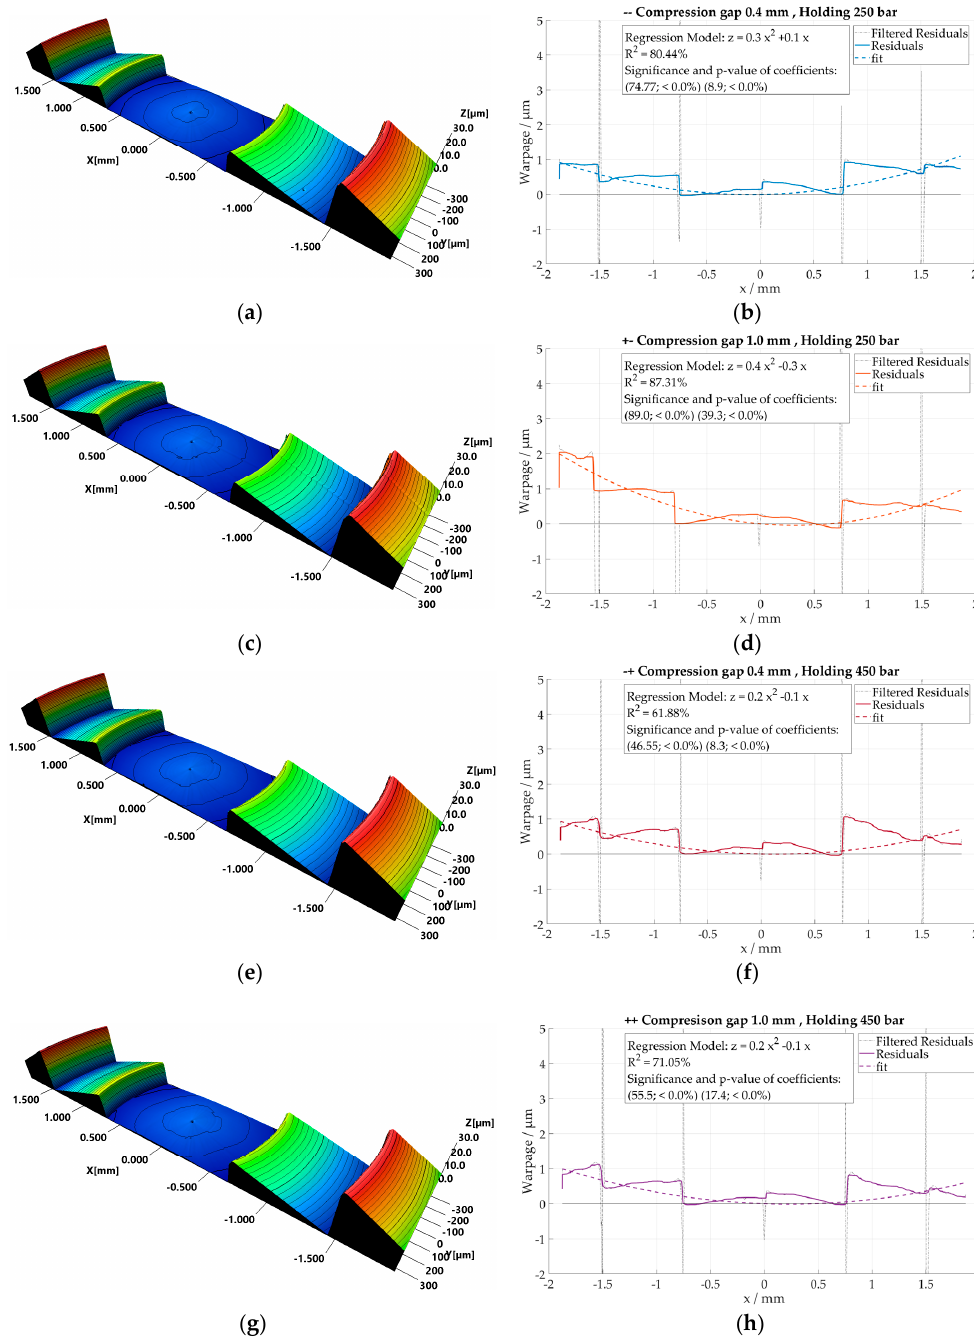
Figure A3. On the left, 3D view of the lens’ central location sampled as in Figure 5. On the right, the residuals of the respective x profiles in comparison with nominal geometry, sampled in the image center. The following process conditions are considered for COP material results: ( a , b ) Compression gap 0.4 mm and holding pressure 250 bar; ( c , d ) Compression gap 1.0 mm and holding pressure 250 bar ( e , f ) Compression gap 0.4 mm and holding pressure 450 bar; ( g , h ) Compression gap 1.0 mm and holding pressure 450 bar.